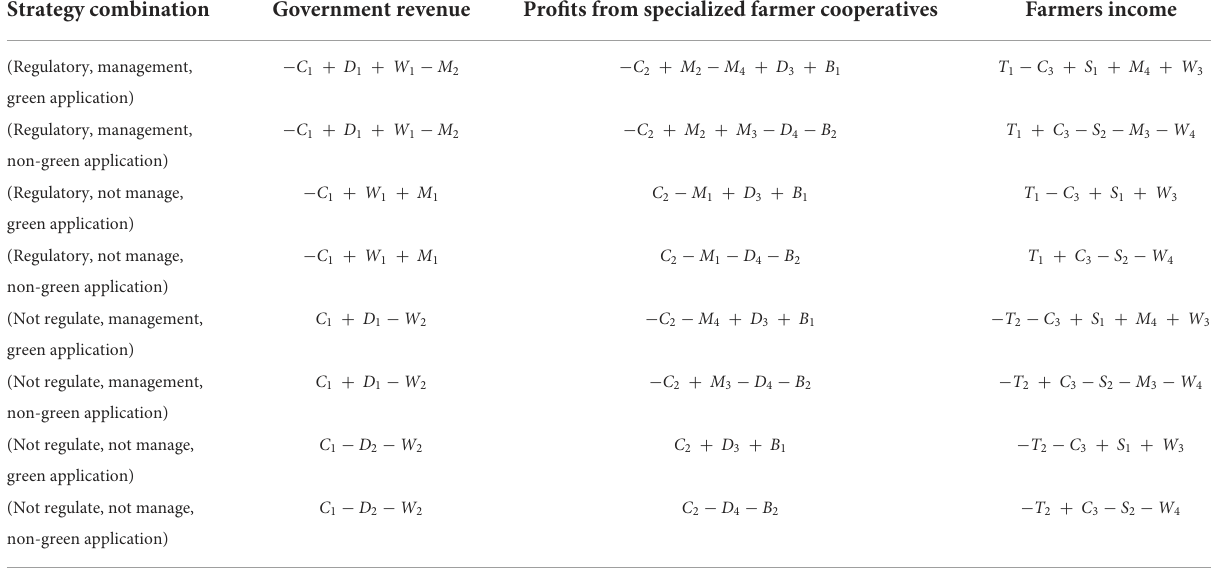
TABLE 1 Revenue combination of tripartite evolutionary game. Strategy combination Government